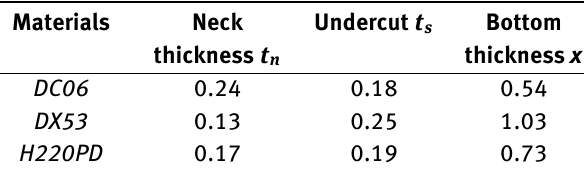
Table 3: The characteristic values of clinched joints (in